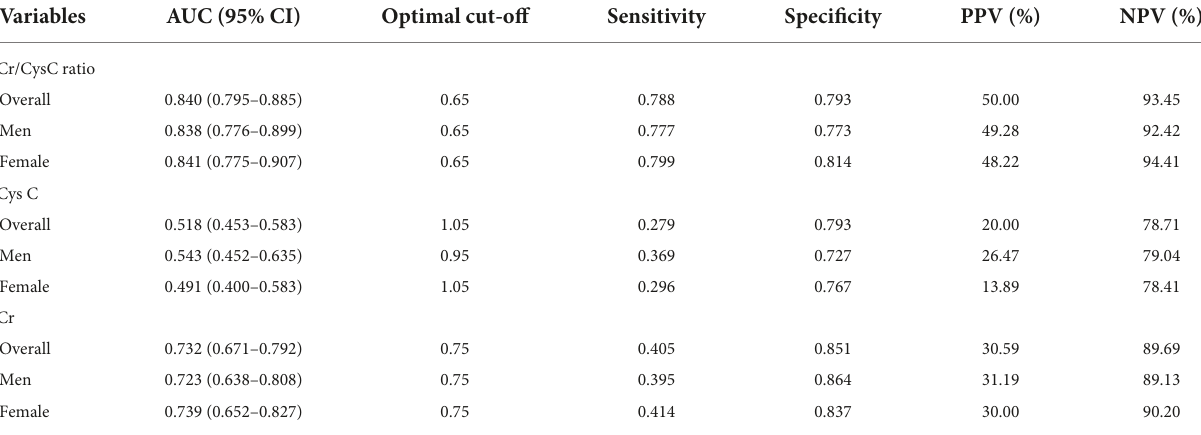
TABLE 4 Serum Cr/CysC ratio, CysC and Cr levels for the diagnosis of